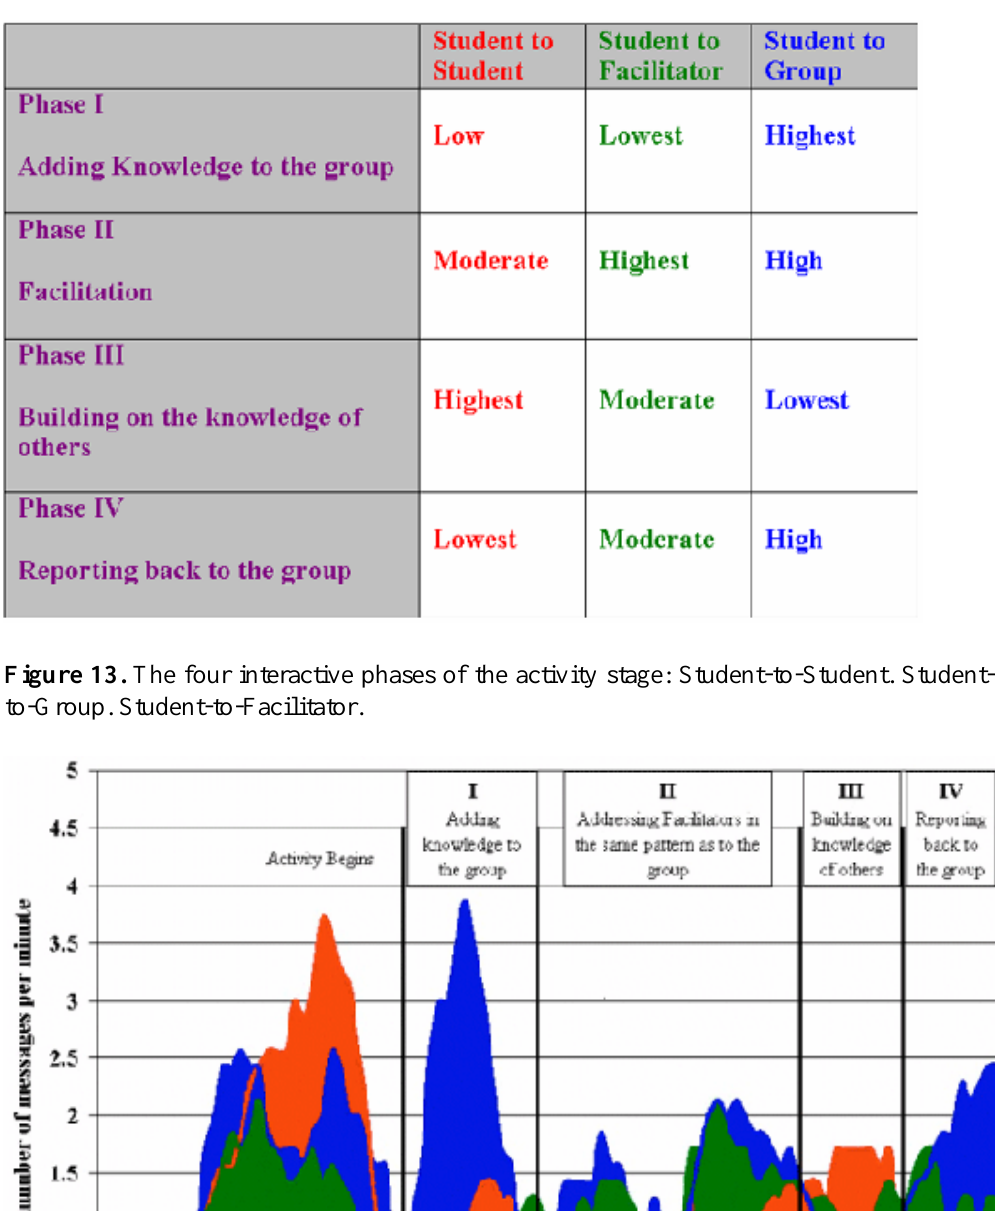
Table 1. Rate of interaction from student to: Student, Facilitator, and Group during the various phases of the Learning Module Activity.